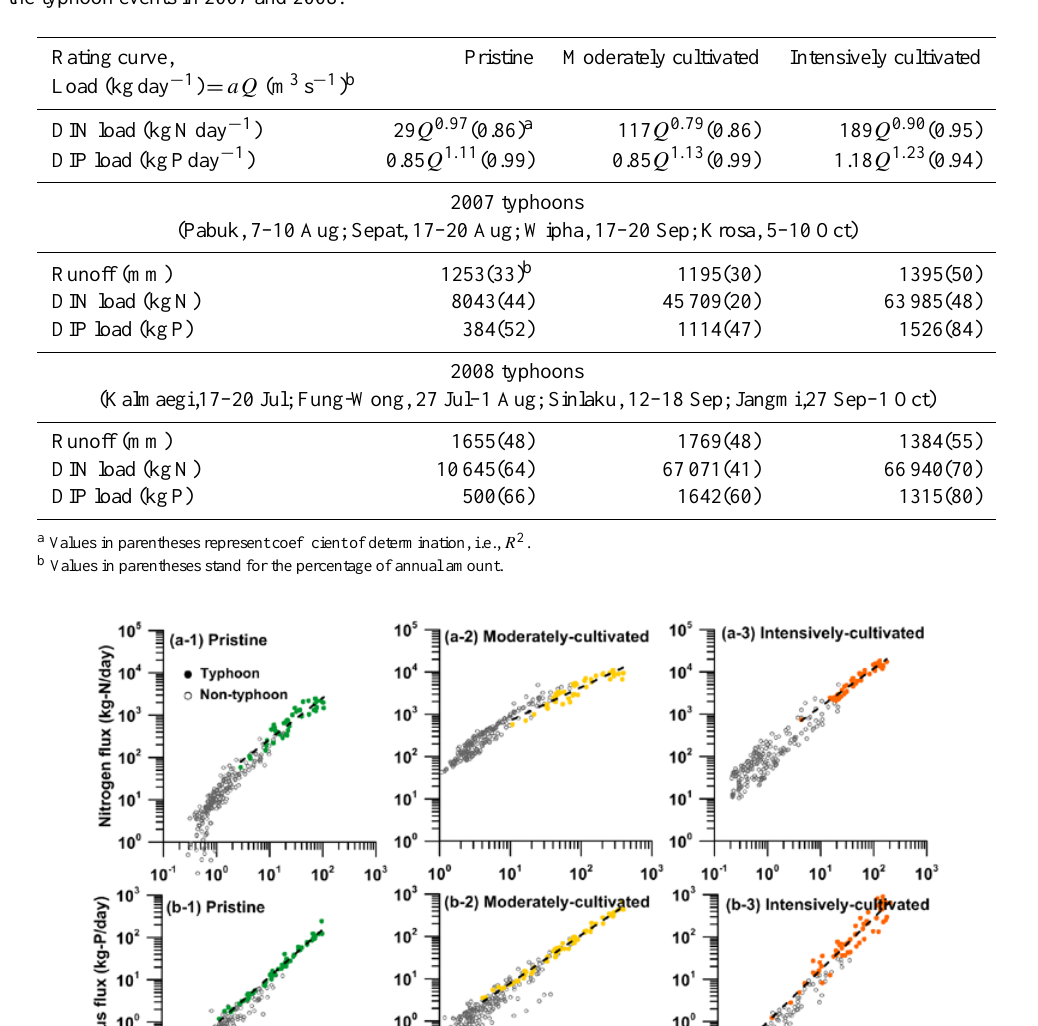
Table 3. The power regression equation of typhoon samples taken for three study watersheds, and the runoff depth, calculated DIN load, and DIP load for the typhoon events in 2007 and 2008.